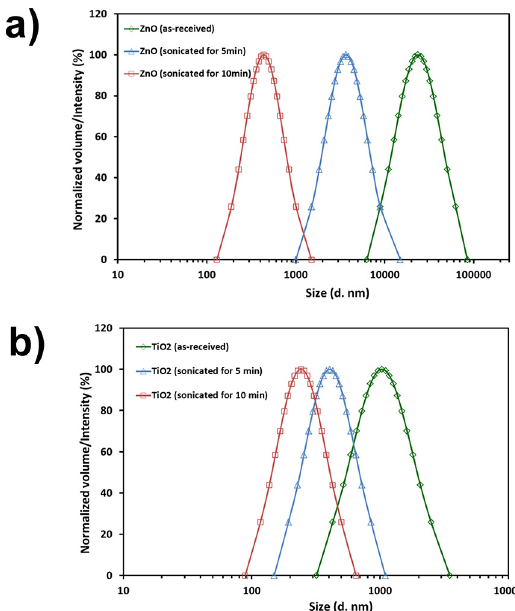
Figure 1. Particle size distribution measured by dynamic light scattering for: (a) ZnO and (b) TiO